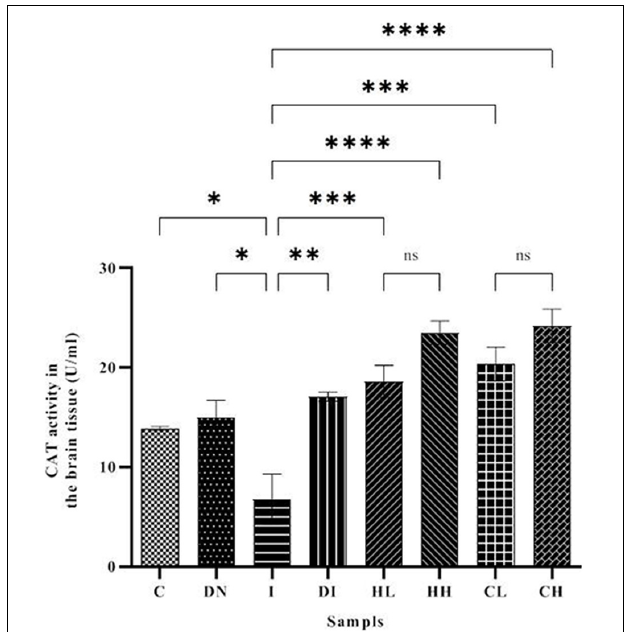
FIGURE 6 | CAT activity in the brain tissue of the treated mice, Group C, control group: Normal saline-receiving group; Group DN, normal saline and deferoxamine-receiving group; Group I, iron dextran and normal saline-receiving group; Group DI, iron dextran and deferoxamine-receiving group; Group HL, low dose hesperidin-receiving group; Group HH, high dose hesperidin-receiving group; Group CL, low dose coumarin-receiving group; and Group CH, high dose coumarin-receiving group (Mean ± SD; ∗ p ≤ 0.05, ∗∗ p ≤ 0.01, ∗∗∗ p ≤ 0.001, ∗∗∗∗ p ≤ 0.0001, ns: